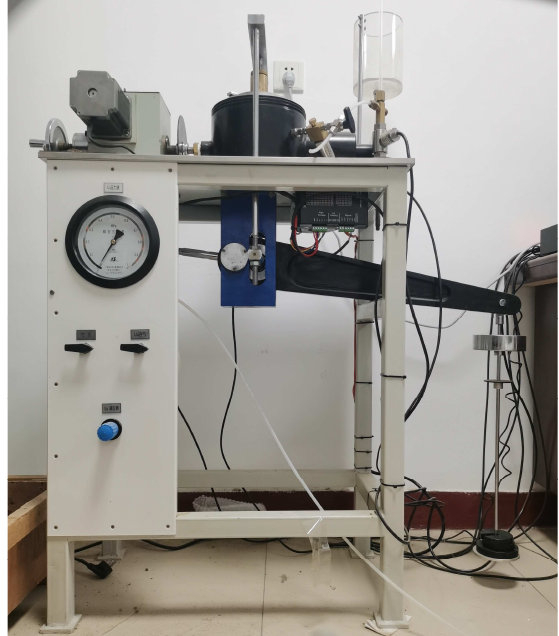
Figure 4. FDJ-20 unsaturated direct shear instrument.